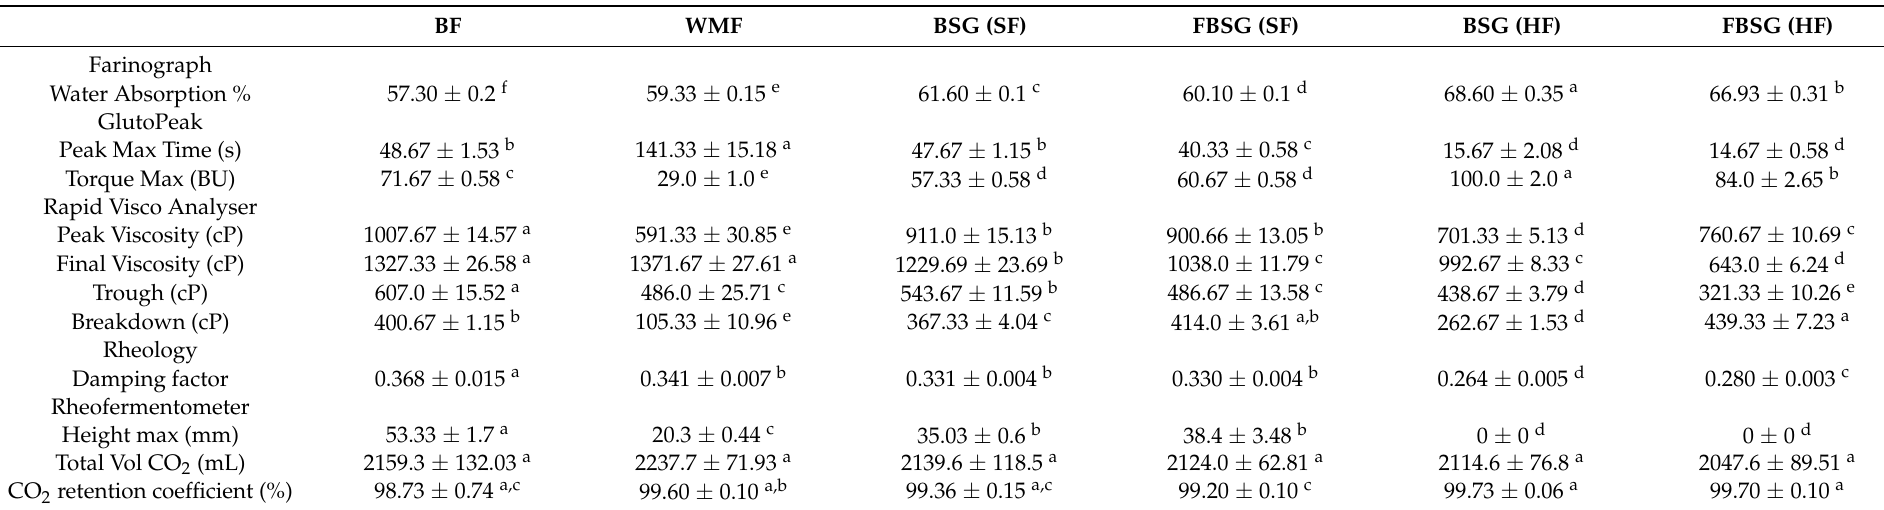
Table 3. Results from the effect of brewers’ spent grain (BSG) and fermented brewers’ spent grain (FBSG) addition at source of fibre (SF) and high in fibre (HF) inclusion levels on farinograph water absorption capacities, gluten aggregation properties, starch pasting behaviour, dough rheology properties, and fermentation capacity. BF and WMF represent results obtained for baker’s flour and wholemeal flour controls, respectively. The values provided represent the mean ± the standard deviation. Values that share the same letter in the same row do not differ